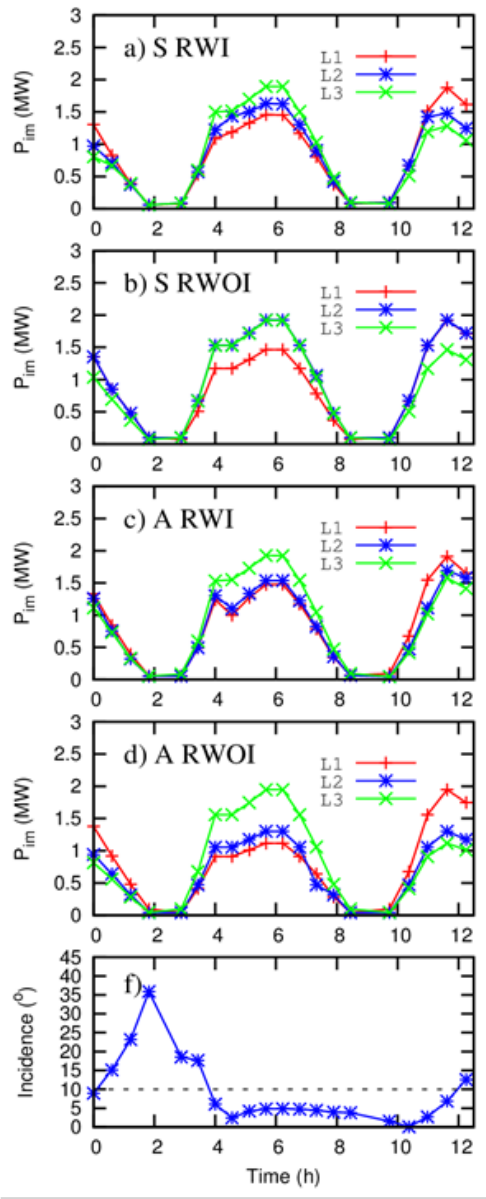
Figure 9. Time evolution of the power: ( a ) Mean power per line Pim (MW) in the case with incidence angle and staggered layout (St RWI); ( b ) mean power per line Pim (MW) in the case without incidence angle and staggered layout (St RWOI); ( c ) mean power per line Pim (MW) in the case with incidence angle and aligned layout (Al RWI); ( d ) mean power per line Pim (MW) in the case without incidence angle and aligned layout (St RWOI); ( e ) incidence angle.